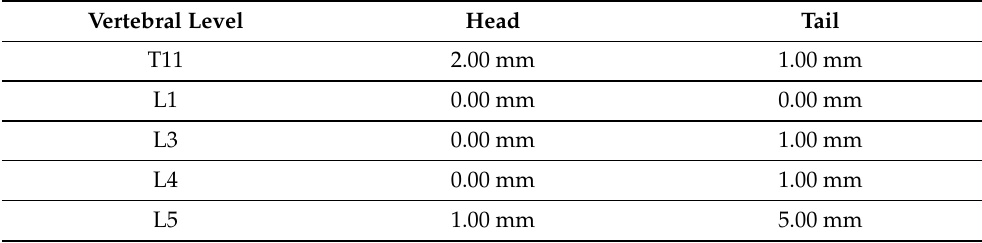
Table 1. Distance between the unconnected trajectories at the head and tail ends are tabulated for the study